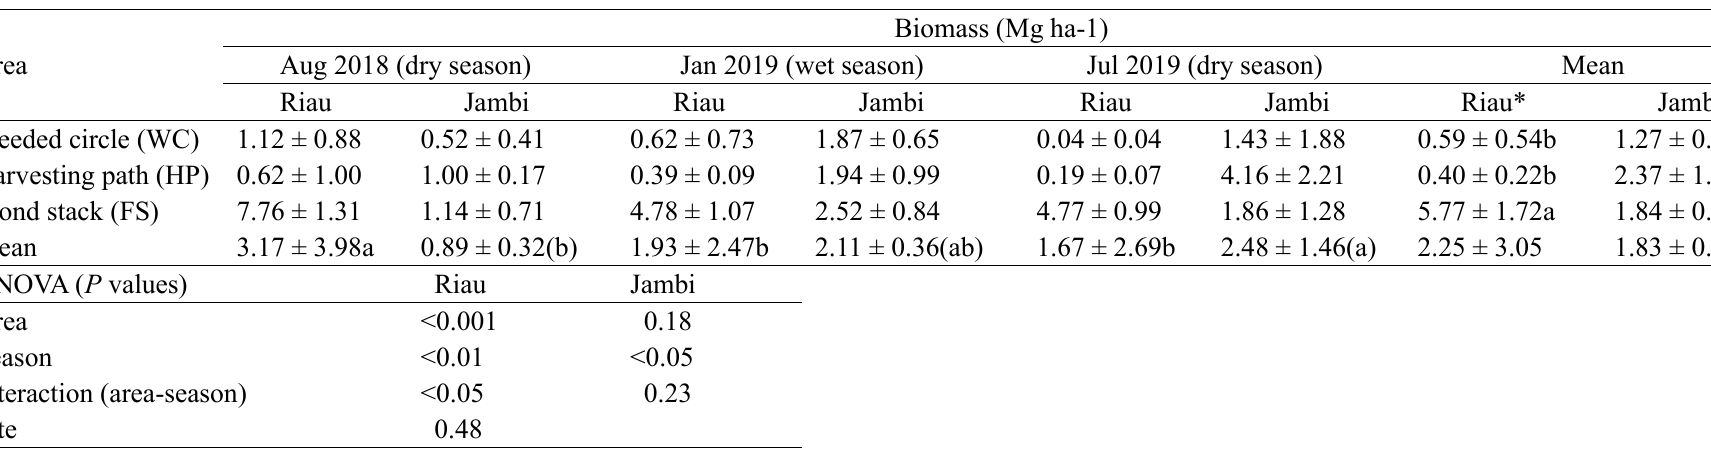
Table 4. Understorey vegetation biomass ( mean ± 1 SD, n = 3). Different suffixes (a, b, etc.) in the column of site means for Riau (*), and in the columns of seasonal means for Riau and Jambi, respectively, denote significant differences ( P < 0.05) according to Tukey HSD test after ANOVA.